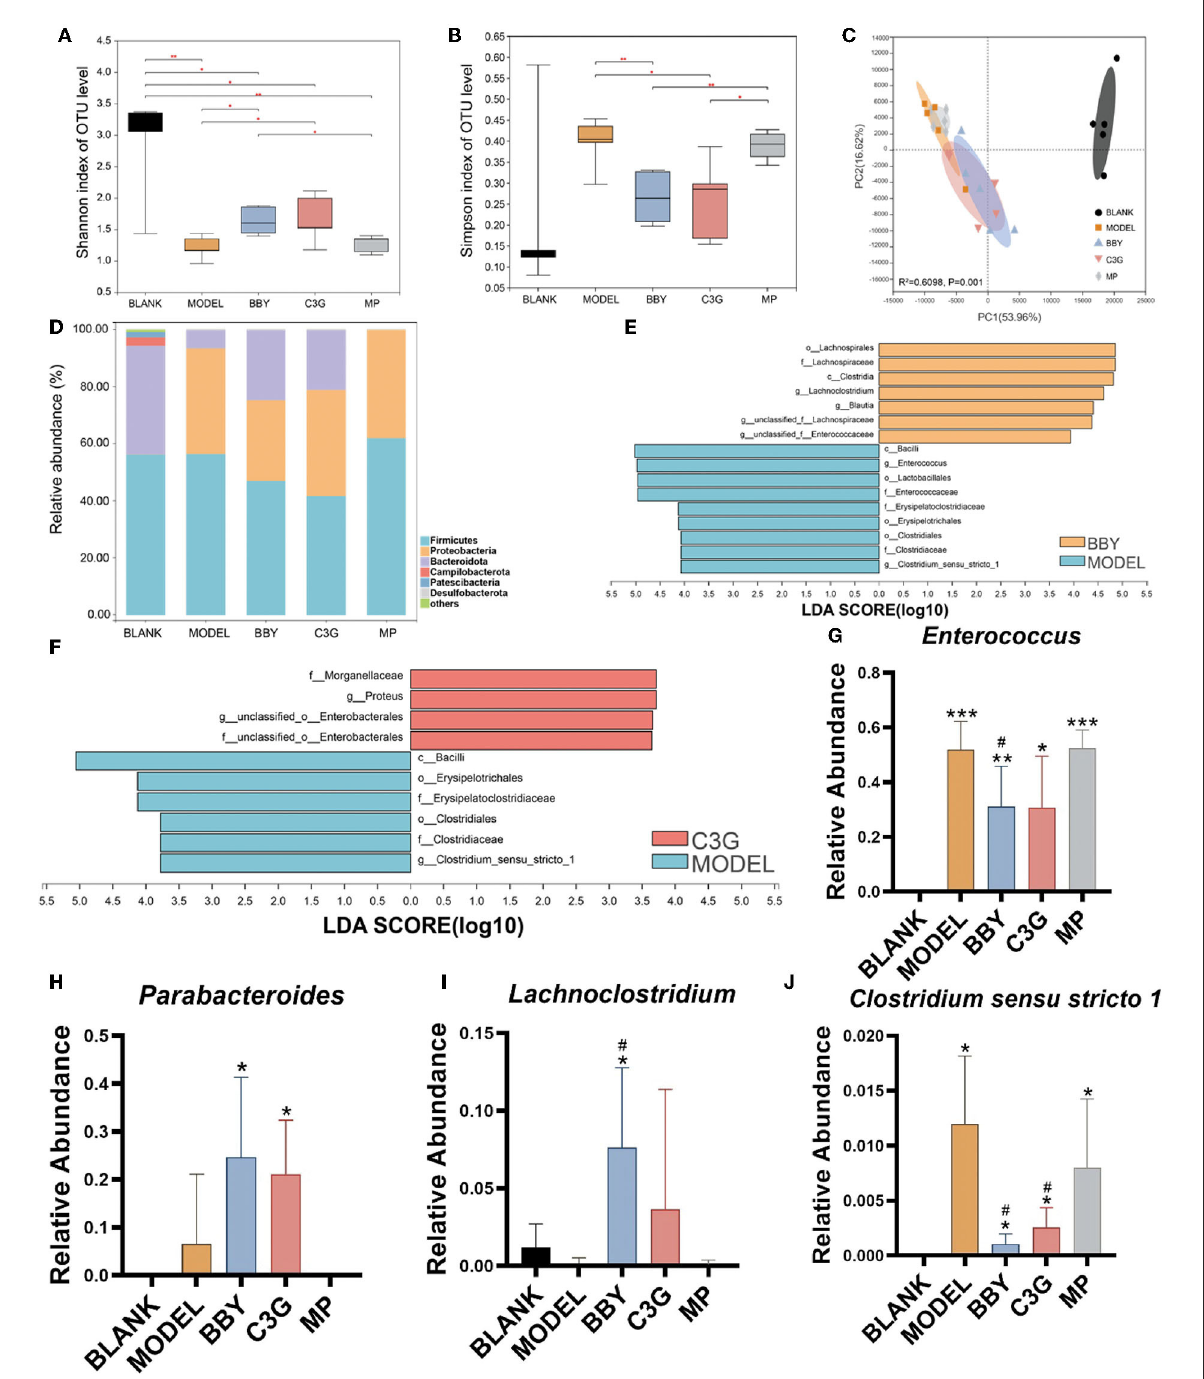
of Enterococcus and Clostridium senus stricto 1 in BBY and C3G groups decreased significantly, while the relative abundance of Parabacteroides and Lachnoclostridium enriched significantly